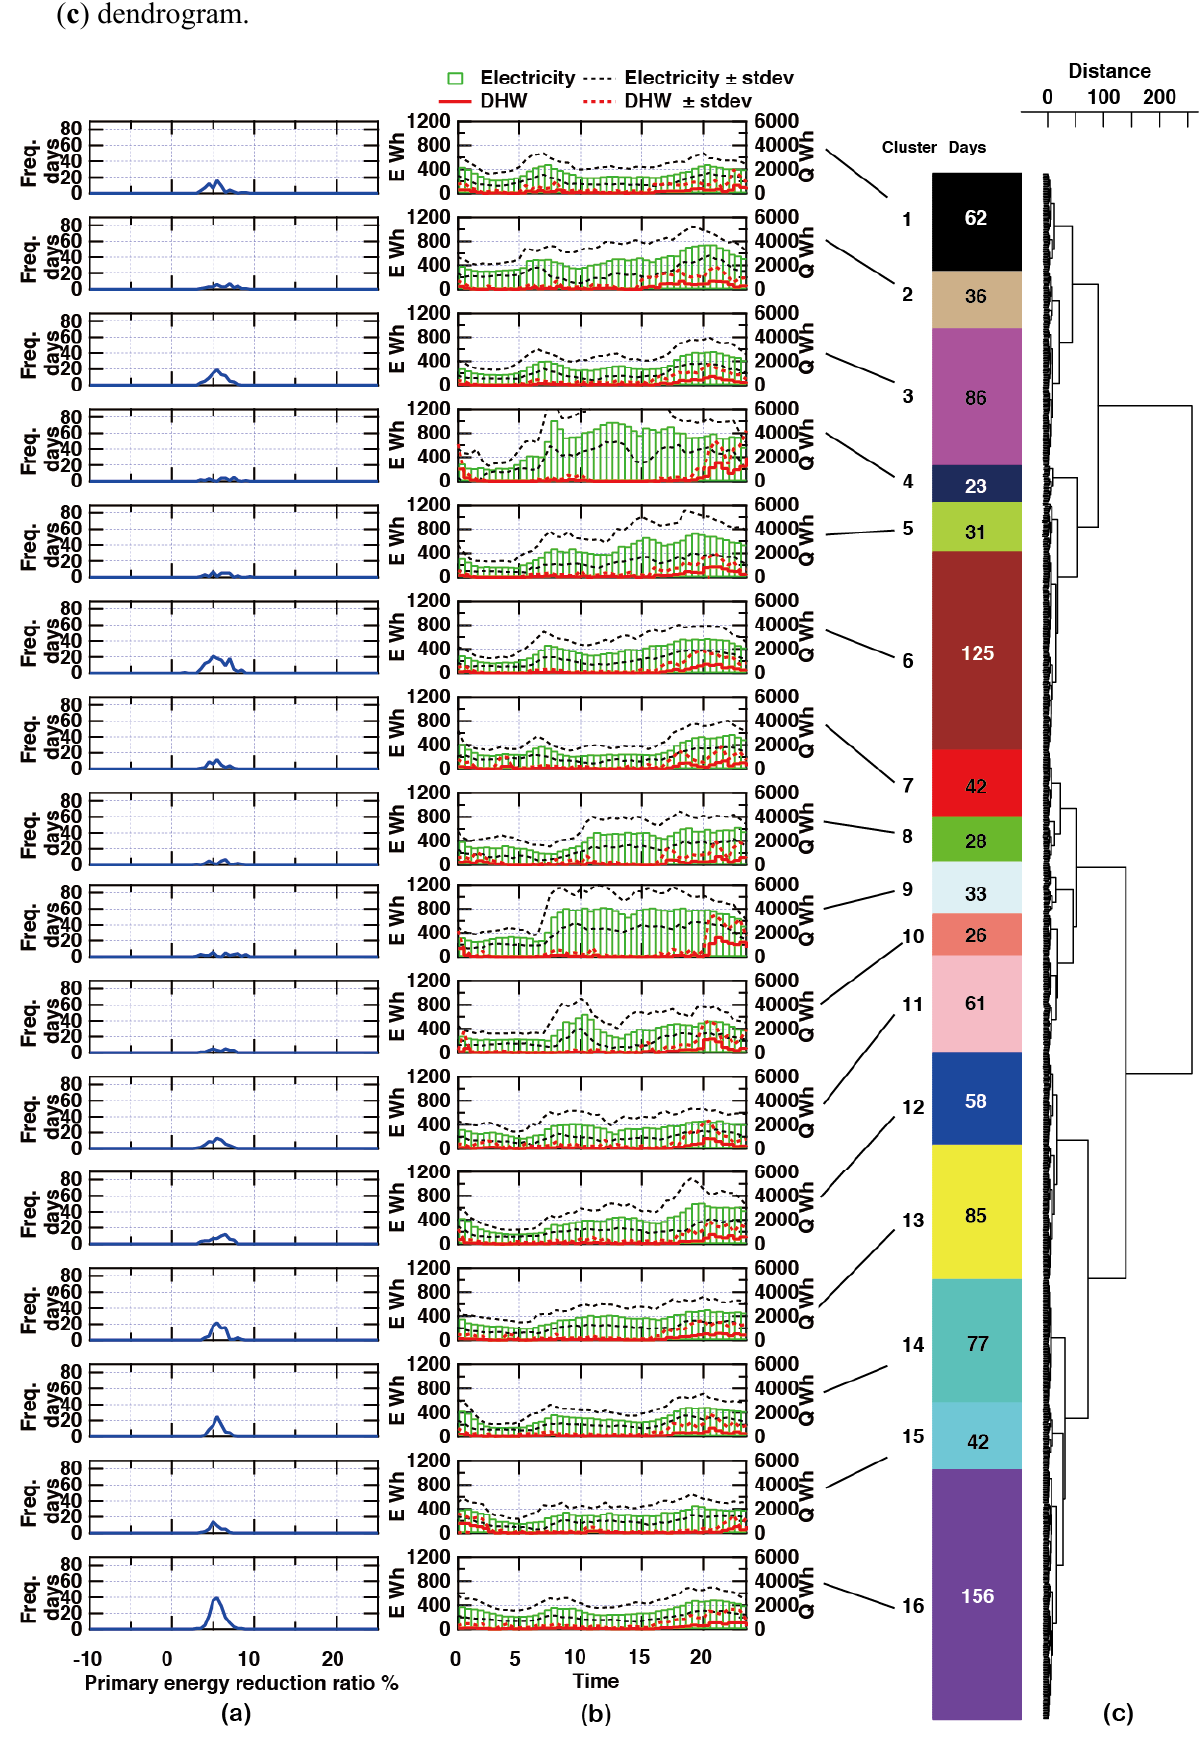
Figure 9. Clusters in Group B. ( a ) primary energy reduction ratio; ( b ) demand patterns; ( c )